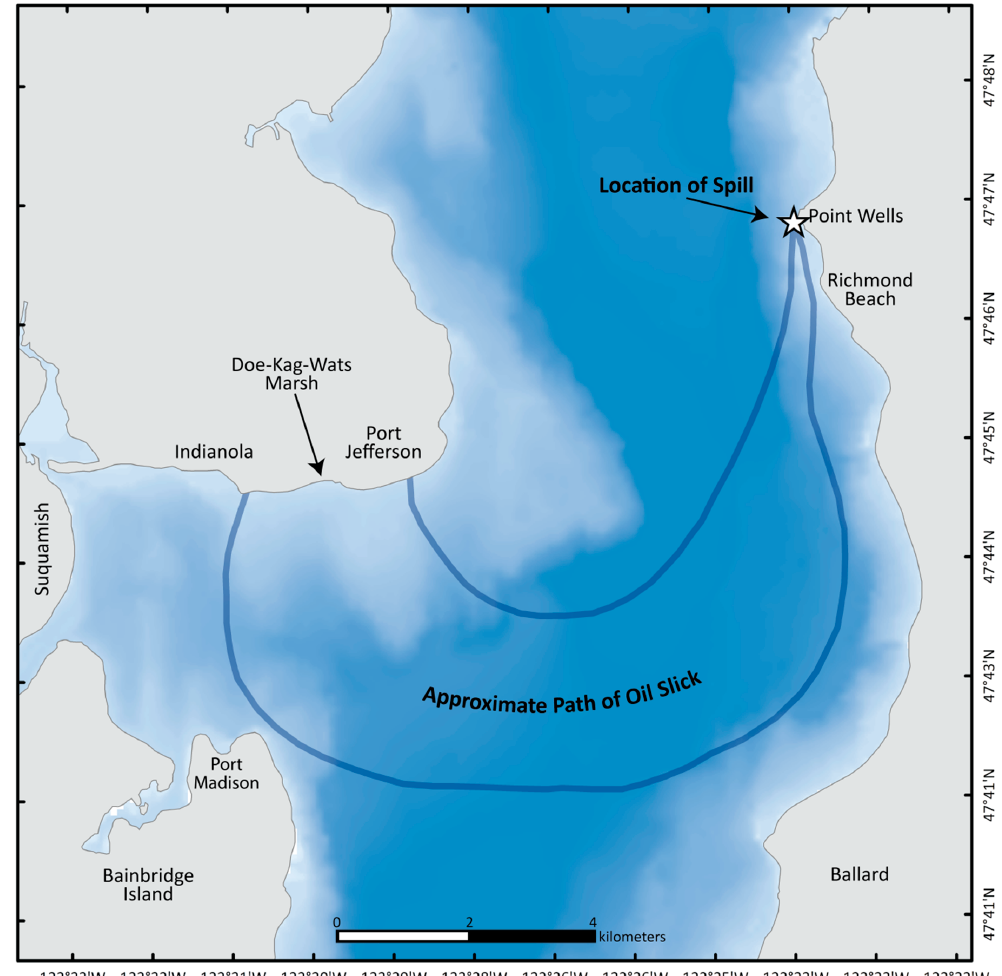
Figure 3. Project area map showing the approximate location and path of the oil surface slick, based on data recorded by ENTRIX, Inc., [10]; see area of interest in Figure 2.